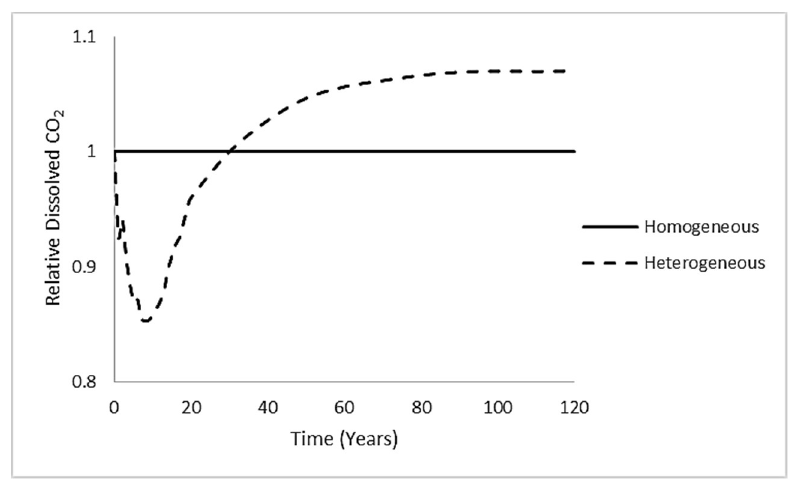
Figure 6. Simulation result for the effect of heterogeneity on CO 2 dissolution in brine vs. time.